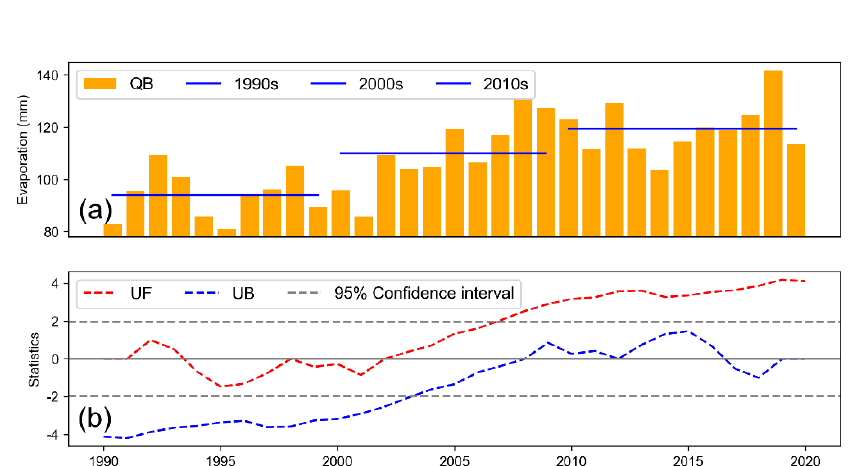
Figure 8. ( a ) Change in evaporation in the Qaidam Basin from 1990 to 2020. The blue solid line represents the decade average of the change in Evaporation. ( b ) Mann-Kendall test results of evaporation. There was no abrupt change in the actual evaporation of the basin from 1990 to